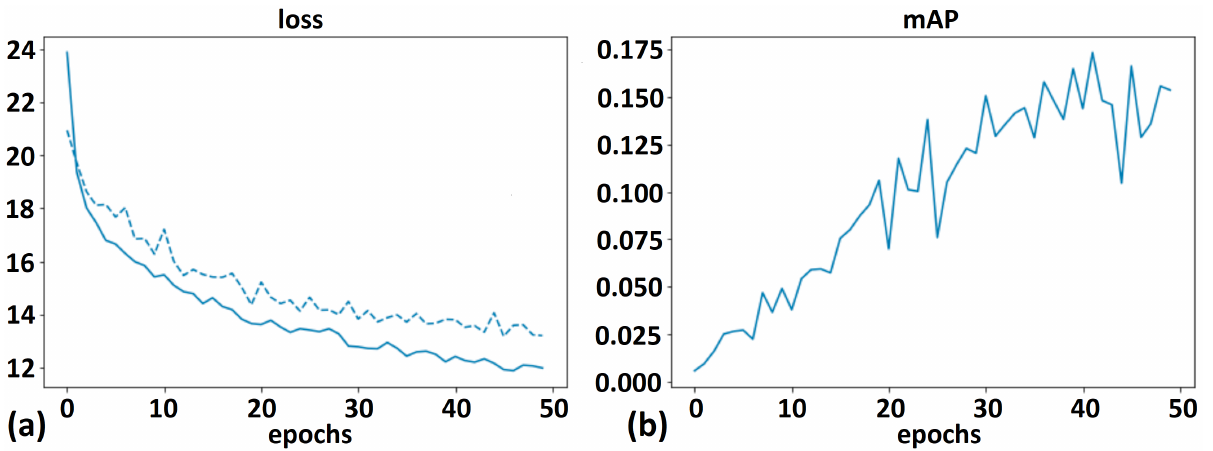
Figure 3. DETR results: ( a ) loss function obtained for the training set (solid line) and the validation set (dashed line) during 50 epochs, for all categories (1st experiment); ( b ) mAP scores obtained for the validation